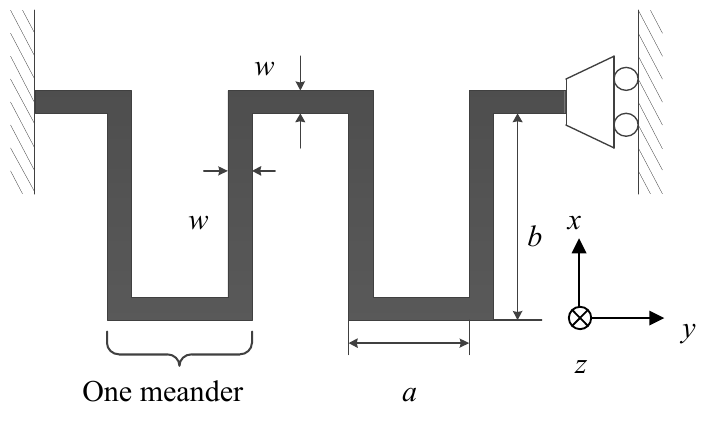
Figure 2. One of the four single folded springs used in the